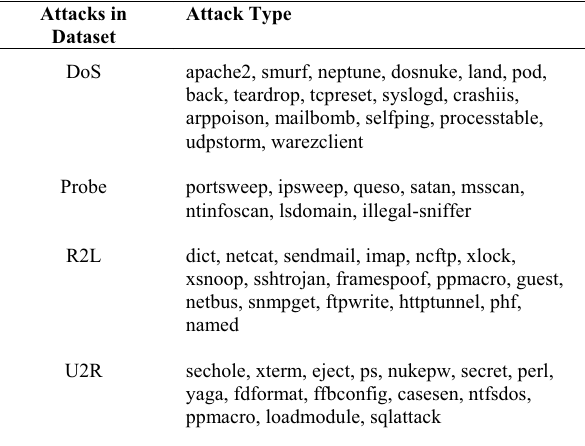
Table 1. Type of attacks grouped as four